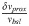
Diverse cellular responses to the various types of presynaptic activity and their link to the characteristics of their firing response function.Note the logarithmic scale for the firing responses in B,C,D. (A) Diverse response to baseline stimulation. (B) Diverse response to unbalanced activity. (C) Diverse response to proximal activity. Note that because the response also shows negative changes of firing rate, the data cannot be log-scaled. Instead, they have been rescaled by the baseline response (i.e. we show δνproxνbsl). (D) Diverse response to distal activity. (E) Diverse response to a synchrony increase.